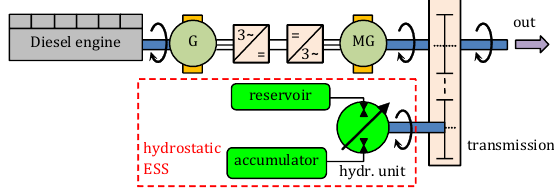
Fig. 6. A parallel hybrid drive of a hydrostatic system and a serial connec- tion of a combustion engine with a generator and an electric motor [17]